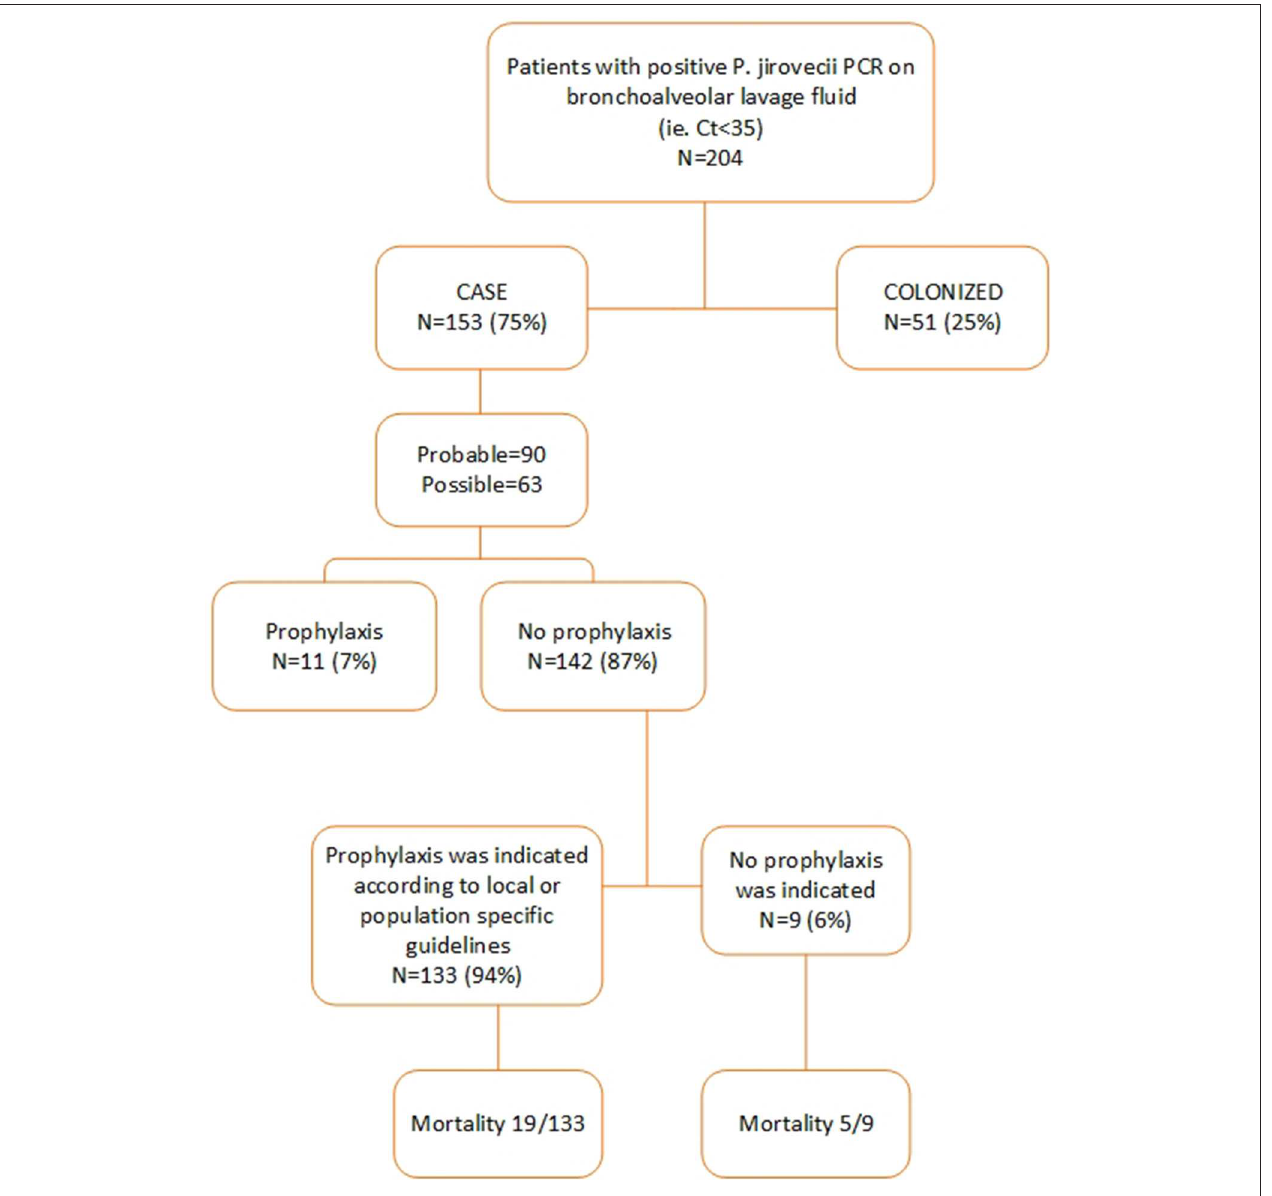
FIGURE 2 | Overview of the (non-)use of prophylaxis.